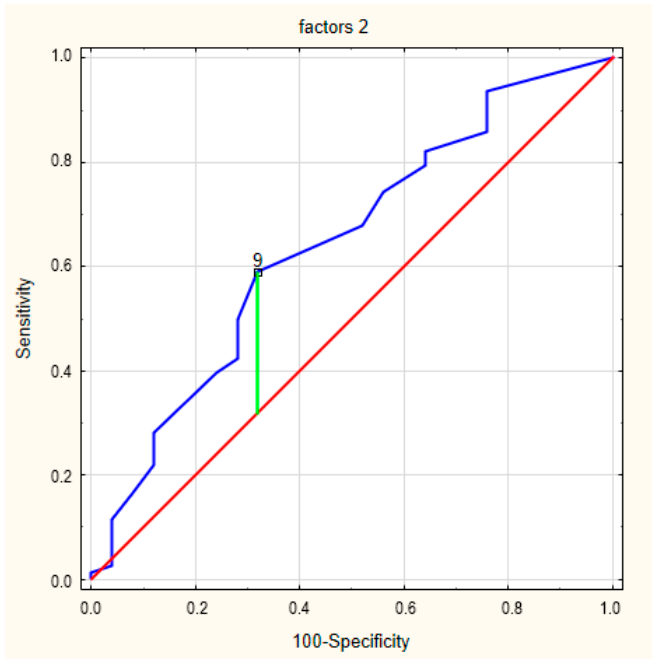
Figure 5. The ROC curves for factor 2 in frailty syndrome.